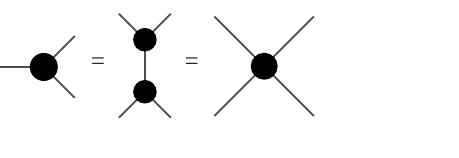
Figure 4 . Merger equivalence relations for N = 4